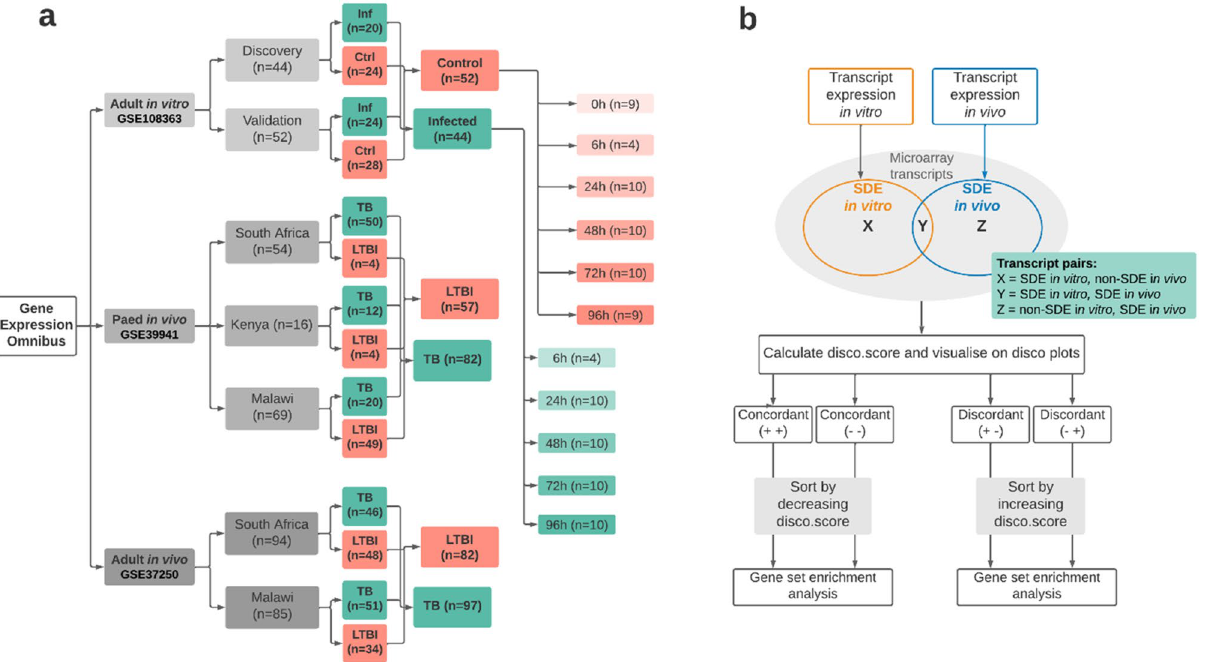
Figure 1. Dataset cohorts and concordance analysis design. ( a ) Three publicly available microarray gene expression datasets deposited in the Gene Expression Omnibus were mined for the analysis. In vitro data derives from an adult whole blood cell infection assay; ‘Ctrl’ and ‘inf’ denote control samples (uninfected) and samples infected with Mtb , respectively. RNA was extracted at five time points (6–96 h) post-infection in the infected and uninfected samples and at 0 h in the control/uninfected group. For in vivo dataset, only Human Immunodeficiency Virus (HIV)-negative and culture confirmed TB patients were included in the analysis. LTBI individuals were used as a proxy for healthy control patients. Sample size is shown for each treatment and cohort group. ( b ) Workflow used to identify concordance and discordance between in vitro and in vivo datasets. Corresponding gene transcripts were mapped to each other to form transcript unions, composed of transcripts significant in vivo mapped to their non-significant counterparts in vitro denoted by X; transcripts significant in both datasets mapped to each other denoted by Y; transcripts significant in vitro mapped their non-significant counterpart in vivo denoted by Z. A transcript pair is said to be concordant if both of its associated log 2 FC values have the same sign. This can be further segmented into concordantly upregulated transcript pairs (both log 2 FC values are positive) and concordantly downregulated transcript pairs (both log 2 FC values are negative). A transcript pair is said to be discordant if its associated log 2 FC values have differing signs, also resulting in two final groups (positive log 2 FC in vitro & negative log 2 FC in vivo ; and negative log 2 FC in vitro & positive log 2 FC in vivo). Disco.score was calculated for each corresponding transcript pair, and its value was proportional to the magnitude of concordance or discordance of said transcript pairs. Concordant transcript pairs were sorted by decreasing disco.score while discordant transcript pairs were sorted by increasing disco.score. Gene Set Enrichment Analysis (GSEA) was performed on each of the four groups of transcript